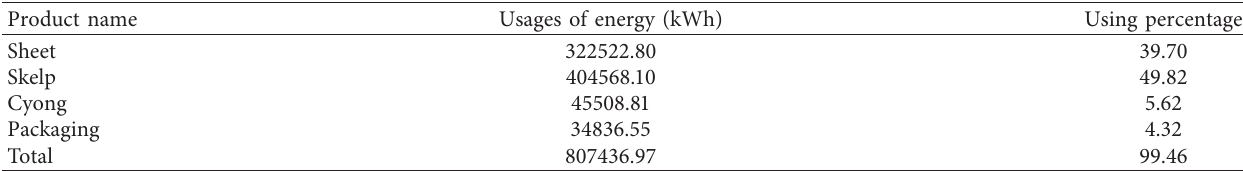
Table 3: Daewoo Steel Factory energy consumption table for the year